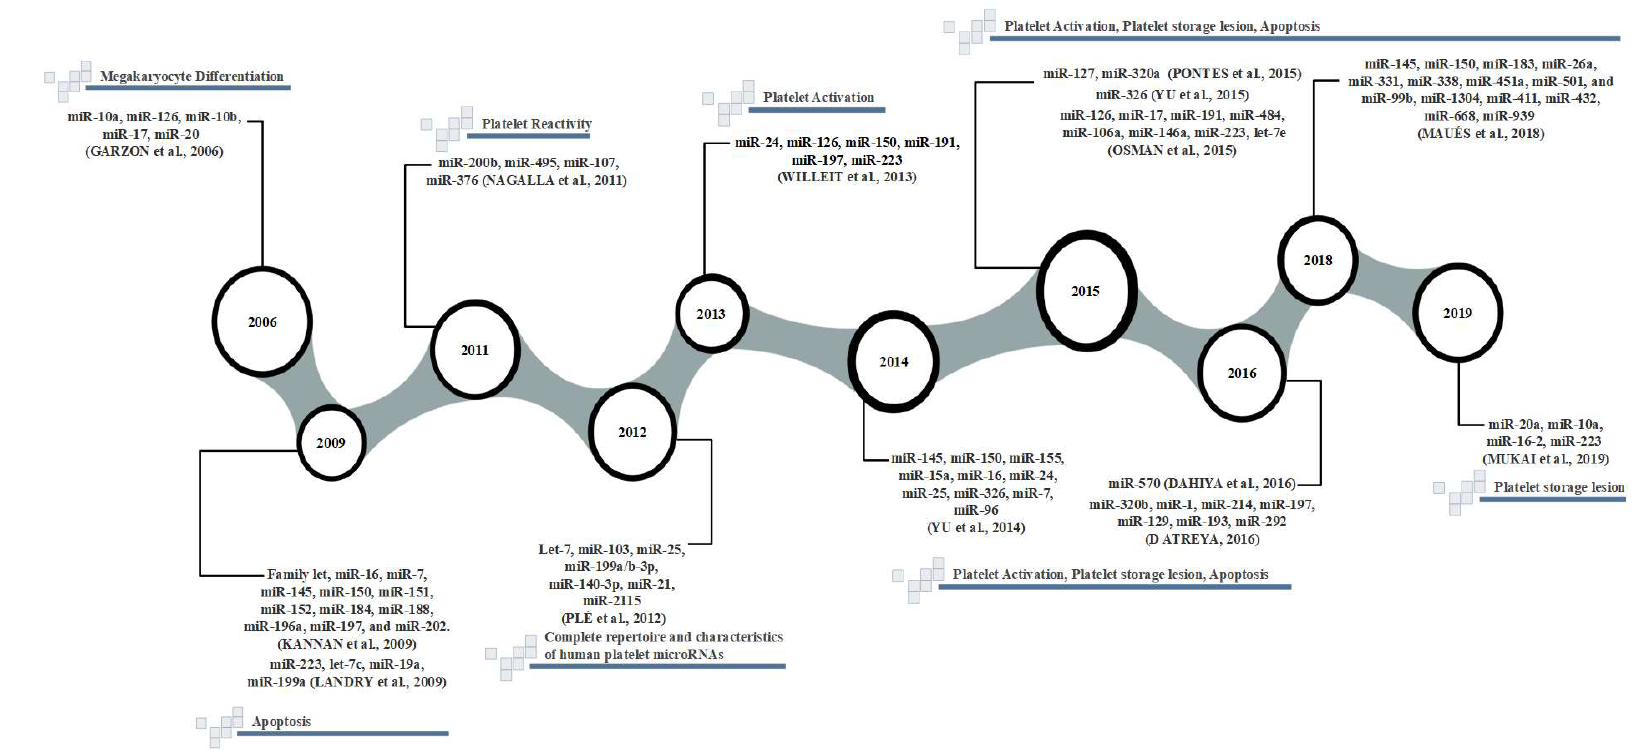
Figure 1. Timeline of major platelet miRNA publications and their relationship to platelet storage lesions.